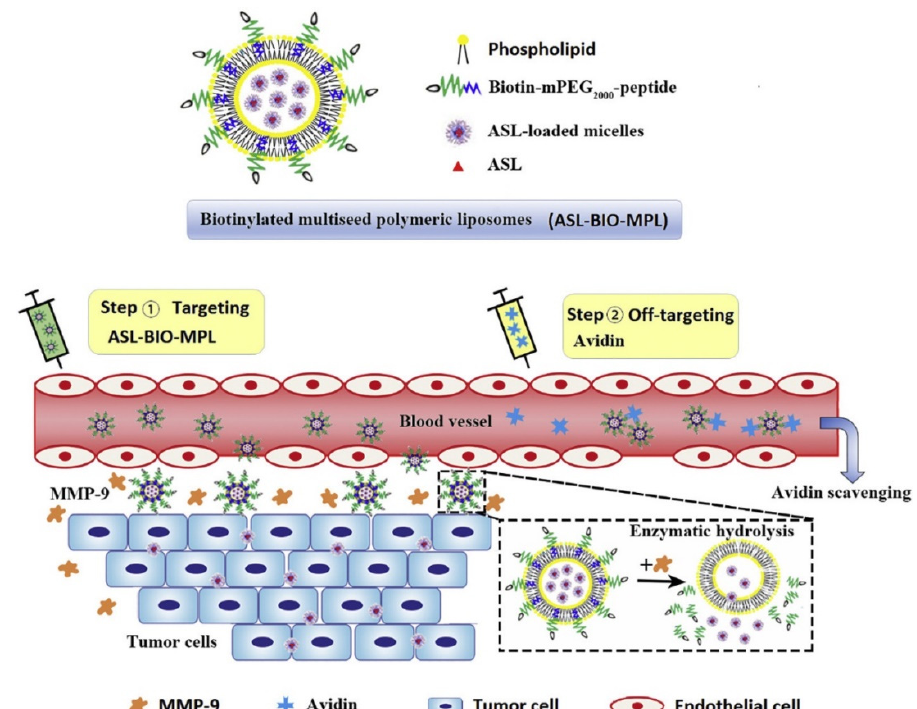
Figure 6. The structure of biotinylated multi-seed polymeric liposomes and mechanism of stimuli-responsive size/ligand adapting strategy with the two-step method of the biotin-avidin system. 1-targeting delivery of nanocarriers to the tumour; 2-off-targeting scavenging of nanocarriers in blood and normal tissues by avidin. With permission from Jin et al. [129].